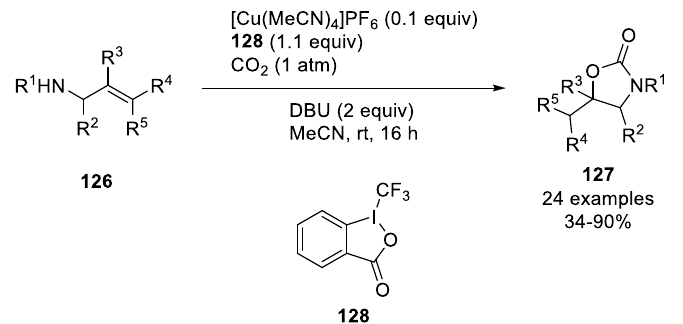
Table 1. Yu’s carboxylative cyclization/alkylation process [60]. The yields of some representative examples are given in the table. R 1 , R 2 , R 3